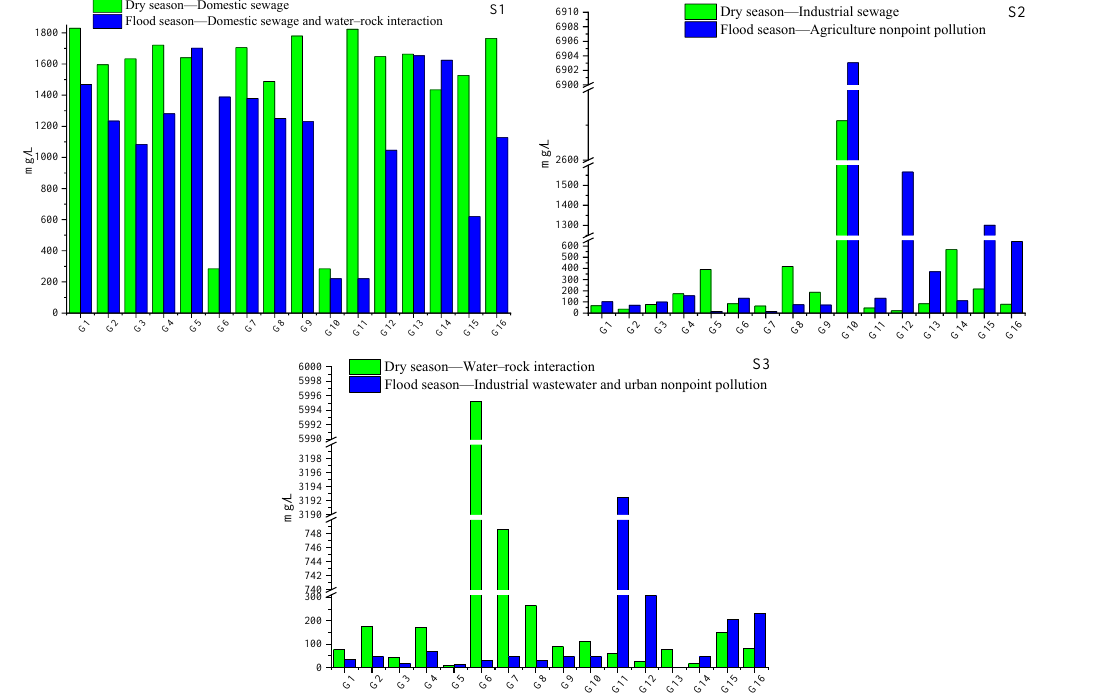
Table 5. Statistic table of the main characteristics of each site. istics of each site. On the whole, the mean contribution of domestic sewage and industrial Sites sewage to 16 sampling sites in the dry season (1489 and 322.5 mg/L) was higher than that in the flood season (1158 and 273.6 mg/L), which is mainly due to the dilution of excessive rainfall in the flood season (Figure 4S1) [18]. The contribution rate of domestic sewage during the dry and flood season was higher in the village sites (1646 and 1277 mg/L) than that in farmland sites (1589 and 1155 mg/L) and county sites (1398 and 873.2 mg/L), which may be due to the domestic sewage substandard emissions in the village region. However, the spatial variation at different land use patterns in the dry and flood season showed that the contribution rate of industrial sewage in village sites (404.2 and 384.4 mg/L) was higher than that in county sites (245.4 and 220.0 mg/L) and farmland sites (147.3 and 95.6 mg/L). In addition, in the dry season, the mean contribution of water–rock interaction at 16 sites was higher in the village sites (810.8 mg/L) than that of the county (116.6 mg/L) and farmland sites (115.5 mg/L). The mean contribution of agricultural nonpoint pollution at 16 sites in the flood season in the farmland sites (970.5 mg/L) was higher than that in the village sites (880.5 mg/L) and county sites (379.0 mg/L). It is noteworthy that the highest contribution of agricultural nonpoint pollution and urban nonpoint pollution was from site 10 (agricultural area) and site 11 (county area) (6903 and 3103 mg/L), respectively. This was closely related to the excessive application of chemical fertilizer in agricultural areas and the heavy traffic in urban areas.